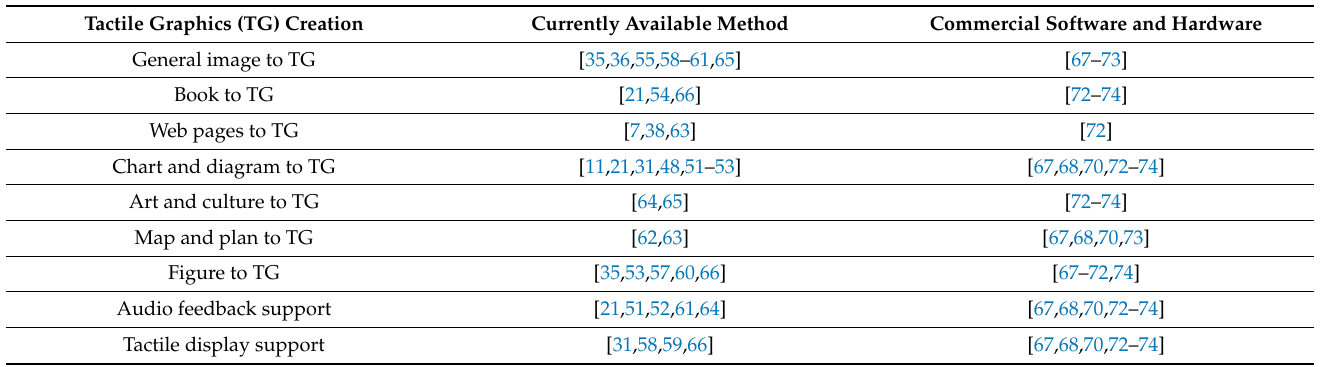
Table 6. Currently available tactile graphics creation methods, software and hardware. Tactile Graphics (TG)